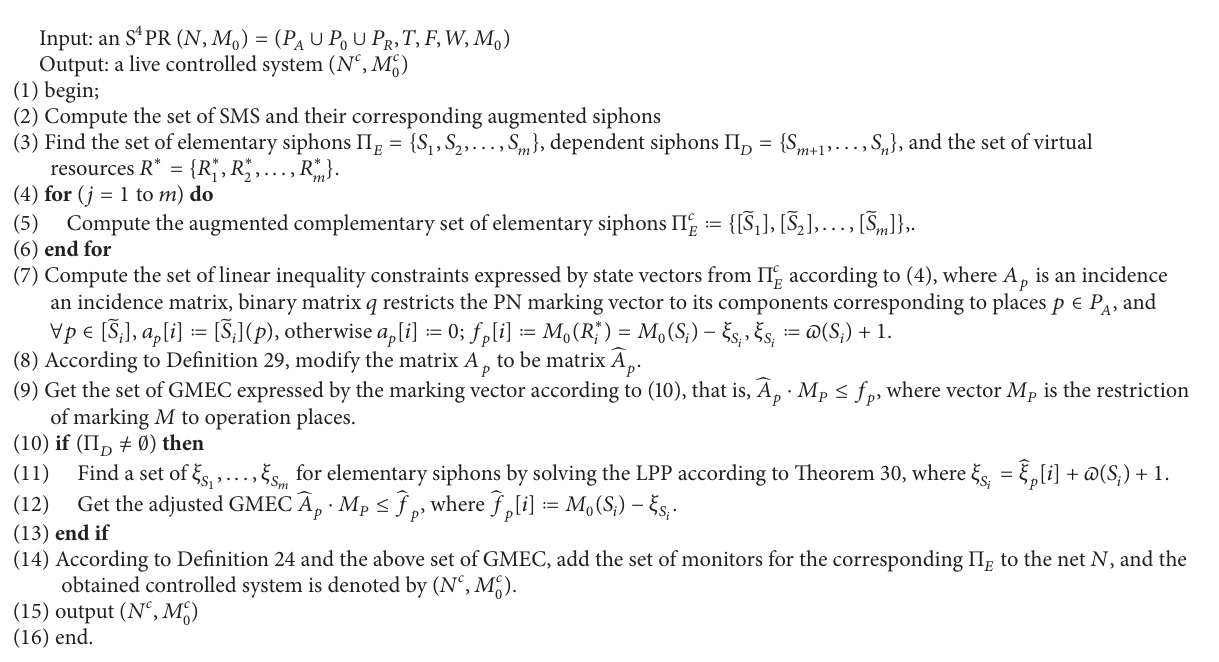
Algorithm 1: A deadlock prevention policy for S 4 PR based on improved elementary